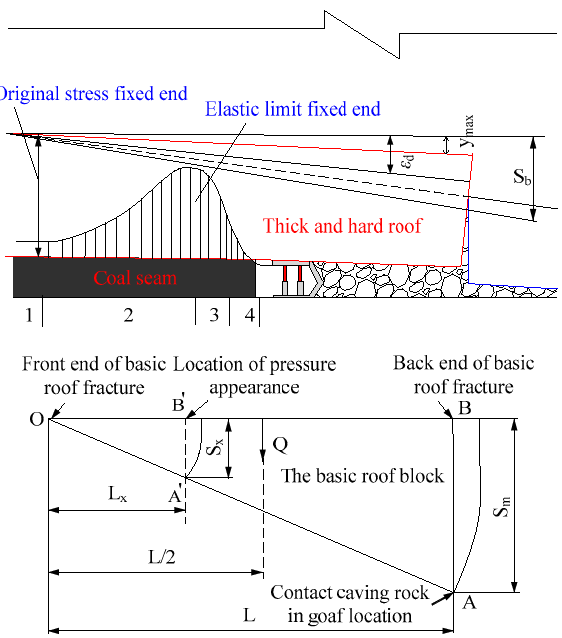
Figure 8. Roof-breaking law of a thick and hard roof.